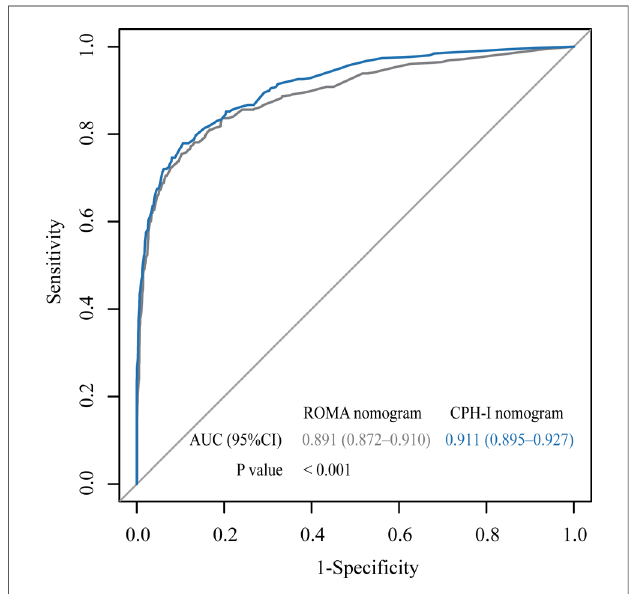
FIGURE 4 Receiver operating characteristic (ROC) curve for nomograms with ROMA or CPH-I. AUC, area under the curve.